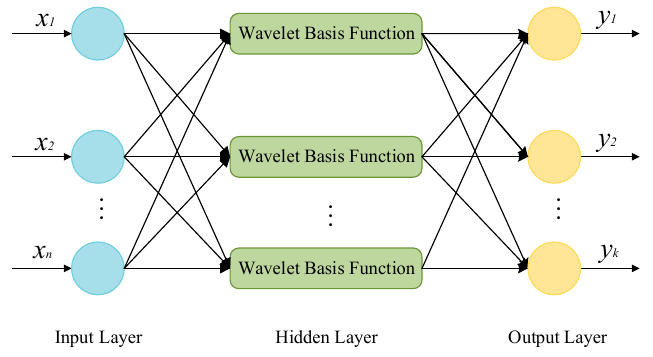
Figure 11. Schematic diagram of WNN structure.